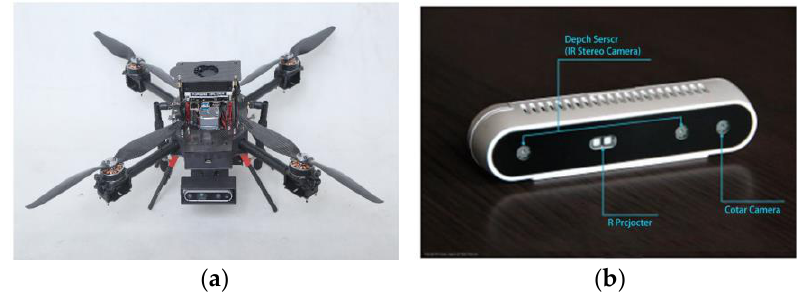
Figure 3. Data acquisition equipment of the study. ( a ) FEISI X450 UAV; ( b ) Intel d435i binocular camera.